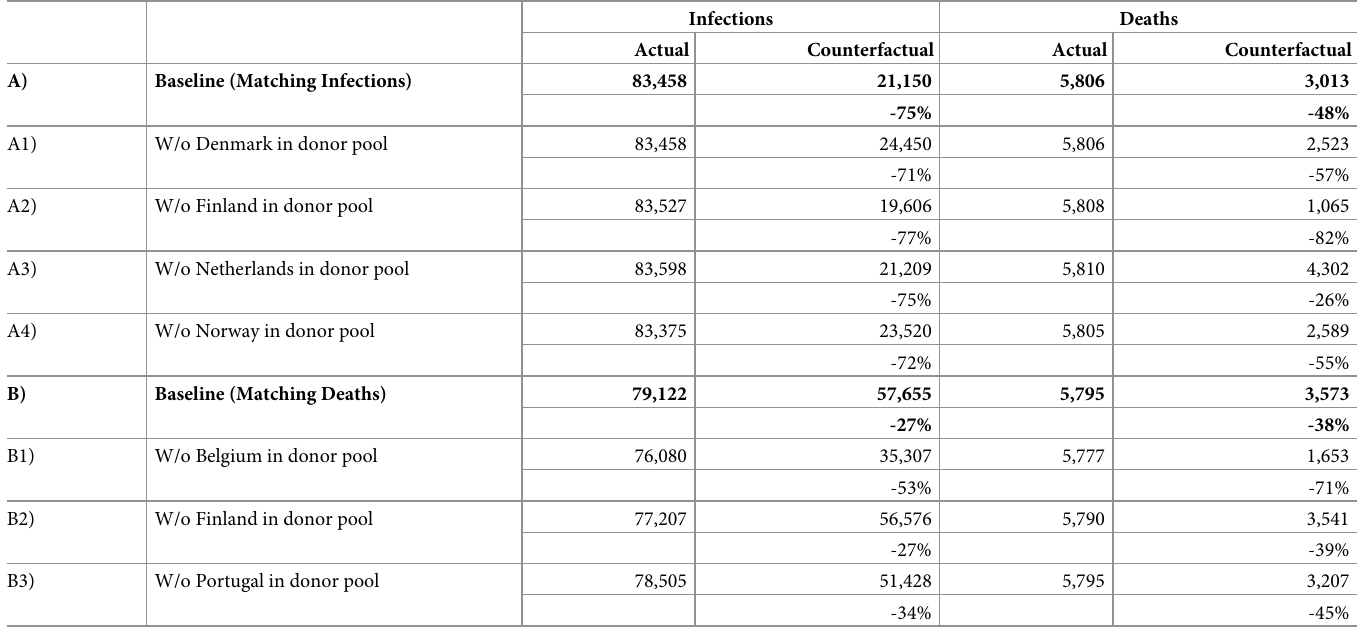
Table 2. The lockdown effect on COVID-19 infections and